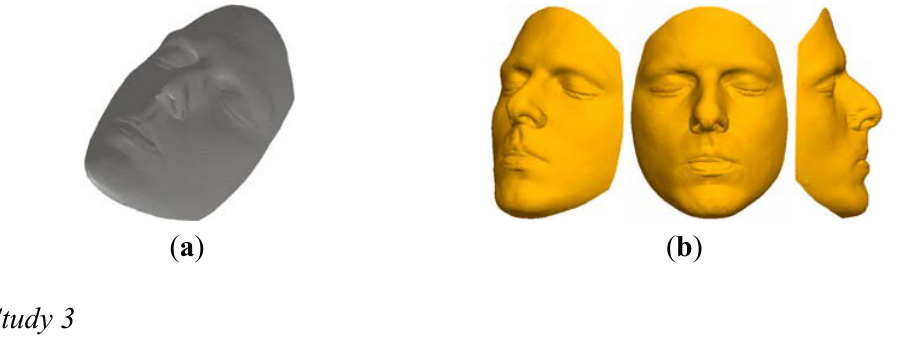
Figure 18. ( a ) Generated cross-sectional curves. ( b ) Generated surface